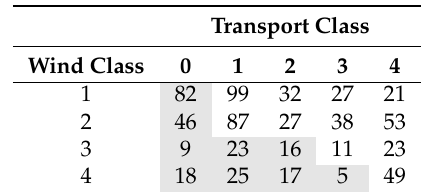
Table 2. Number of events sorted according to their wind class (Table 1) and transport class (Figure 4). The limited events are coloured in